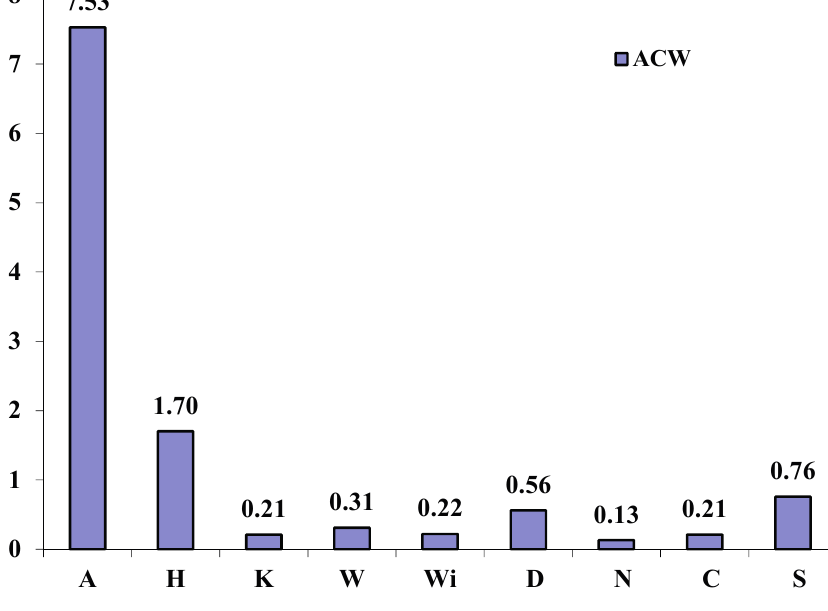
Figure 1. Values (µmol ascorbic acid·g − 1 sample) of antioxidant capacity of the water soluble compounds (ACW) in edible algal products (A— Eisenia bicyclis ; H— Hizikia fusiformis ; K— Laminaria japonica ; W, Wi— Undaria pinnatifida ; D— Palmaria palmata ; N— Porphyra tenera ; C— Chlorella pyrenoidosa ; S— Spirulina platensis